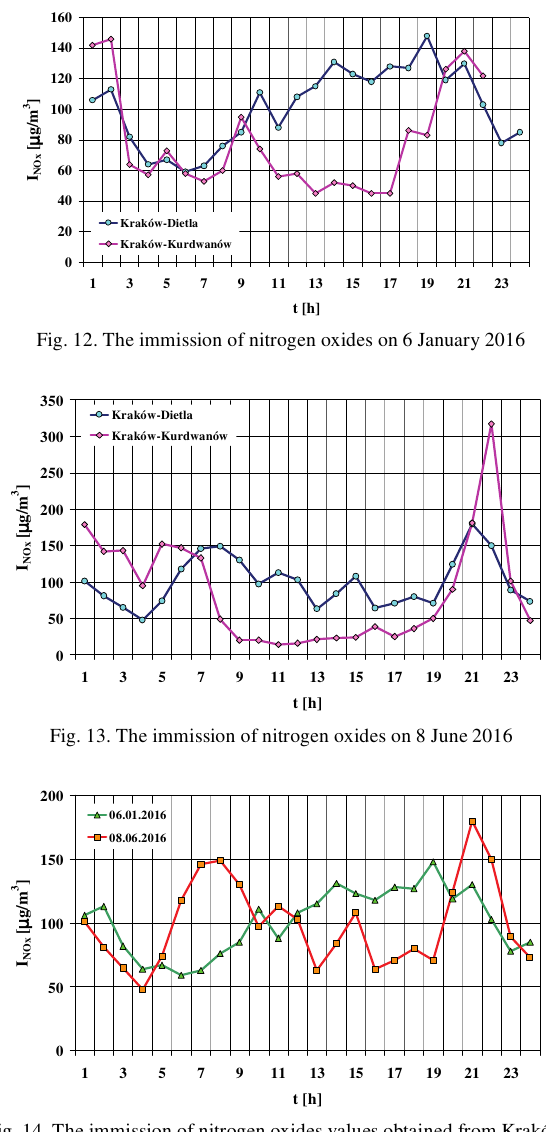
Fig. 14. The immission of nitrogen oxides values obtained from Kraków– Dietla station on 6 January 2016 and 8 June 2016